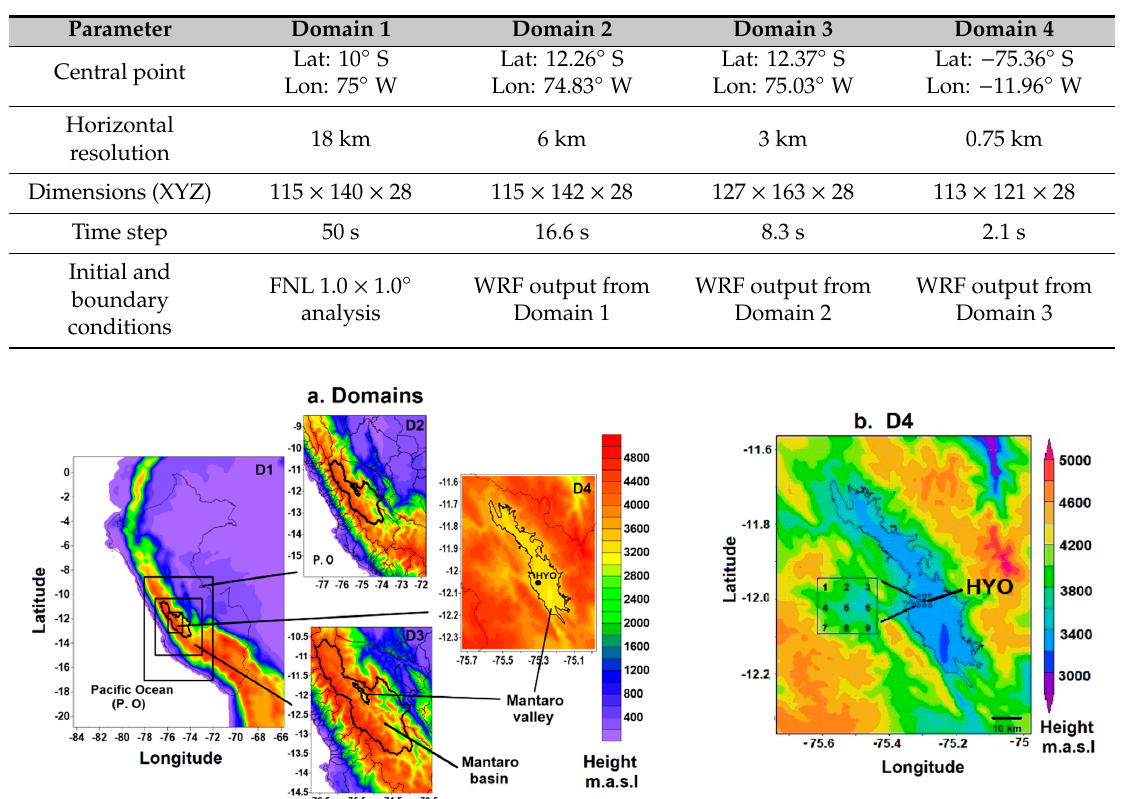
Table 1. Main parameters of the four nested domains.